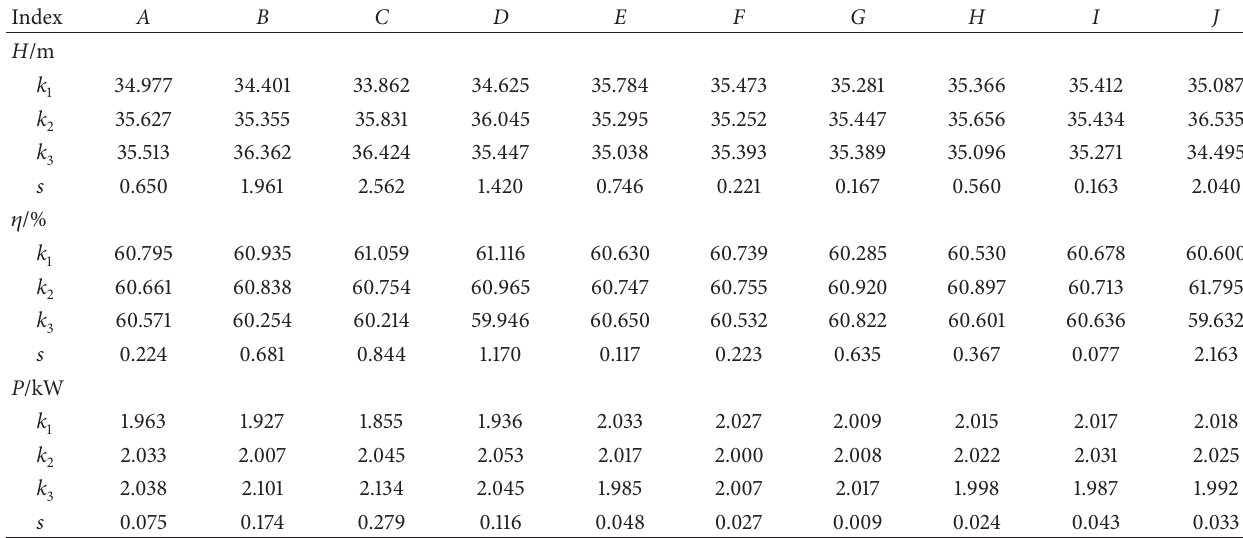
Table 9: Range analysis of orthogonal test